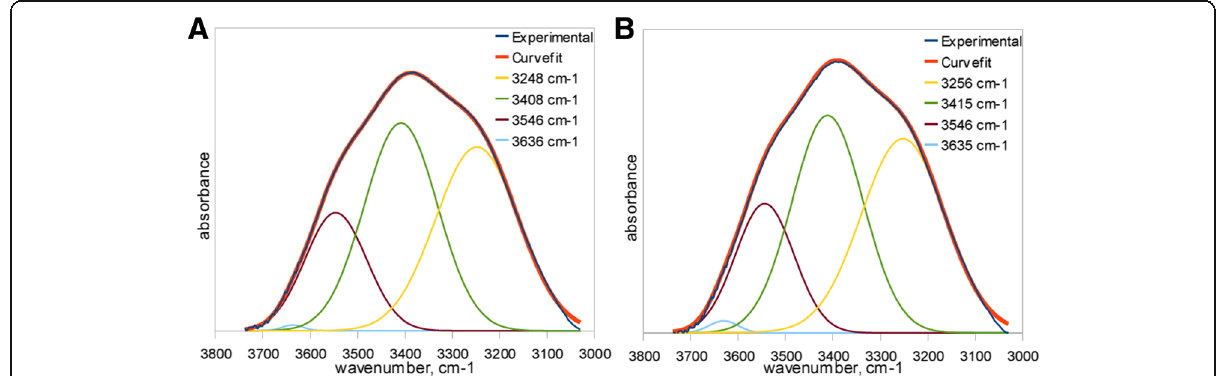
Fig. 4 Demonstration of OH sub-bands fitting procedure for ( a ) deionized water and ( b ) saline